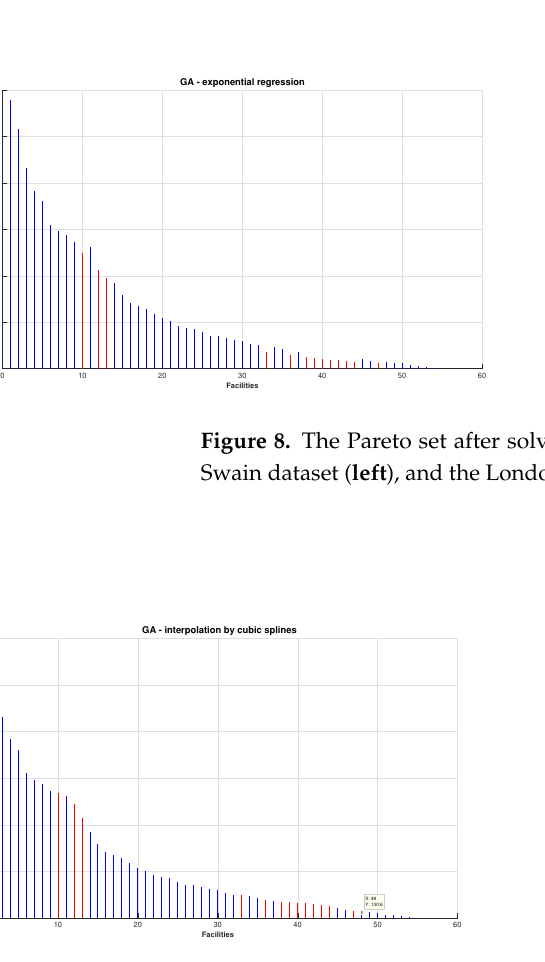
Figure 9. The Pareto set after solving the FLP complemented via cubic spline for: the Swain dataset ( left ), and the London dataset ( right